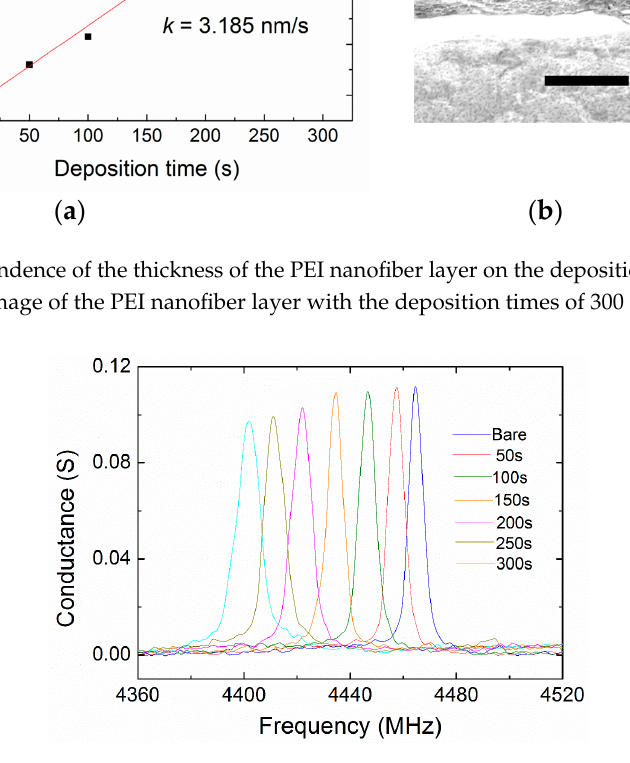
Figure 5. The admittance curves of the bare FBAR device and PEI nanofibers-coated FBAR devices. The times of electrospinning deposition were 50–300 s.